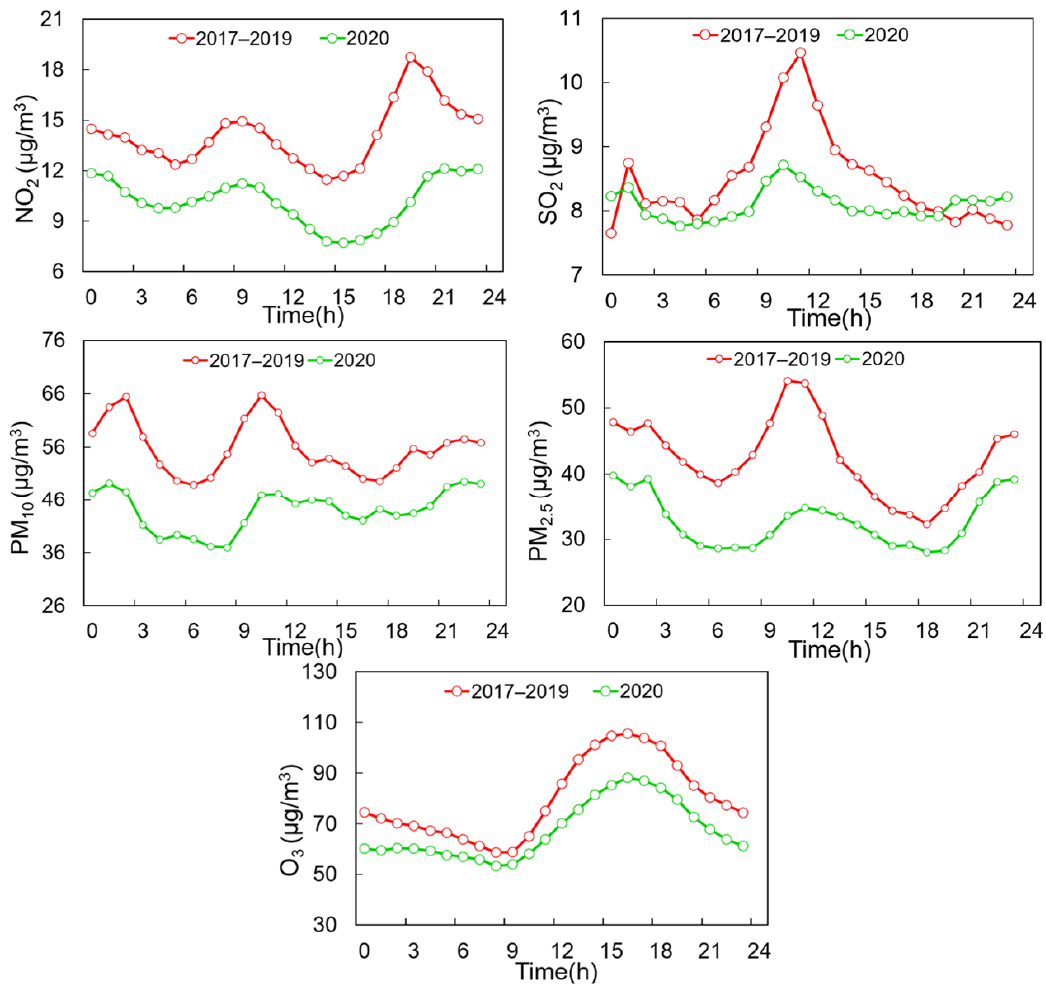
Figure 6. Diurnal variation of ground measured air pollutant concentrations Beihai in Beihai between 25 January and 25 February averaged over the previous three years (2017–2019, red line) and in 2020 (the COVID ‐ 19 lockdown).